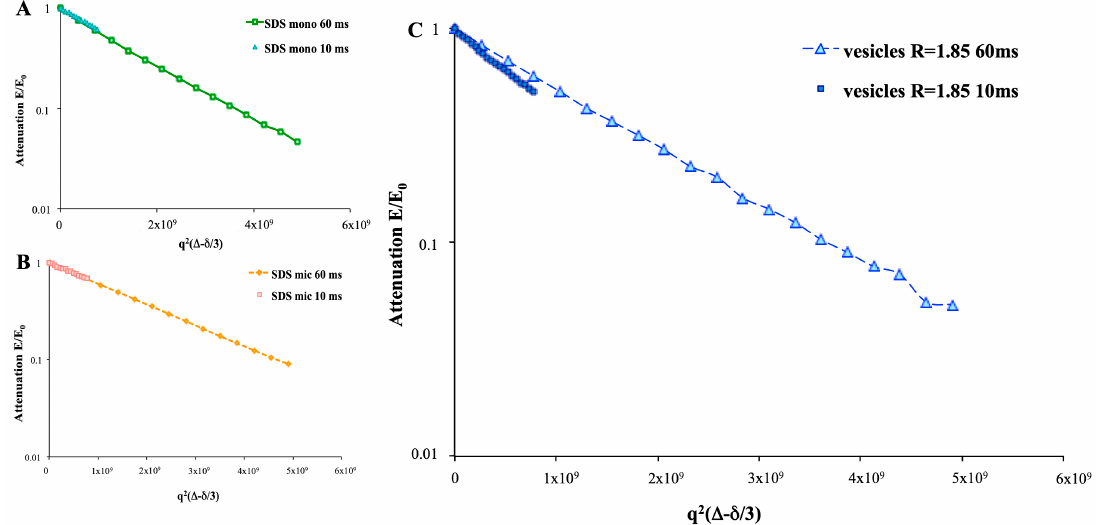
Figure 6. Plot of the echo decays at different diffusion intervals at 30 °C ( Δ = 10 ms, Δ = 60 ms) for ( A ) an SDS monomeric solution, ( B ) SDS micellar solution (10 mM), and ( C ) vesicles at R = 1.85.